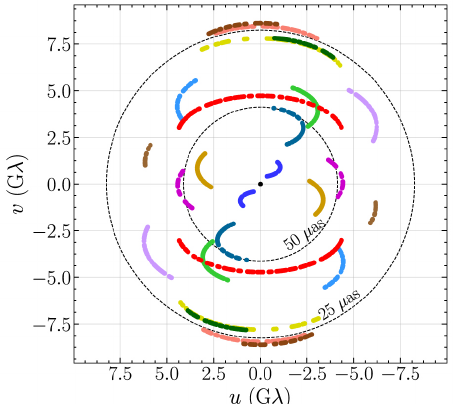
Figure 2. From Ref. [1] (one panel from original Figure 2). EHT baseline coverage, where dimension- less coordinates u = ( u , v ) give the projected baseline vector for each antenna pair in units of the observing